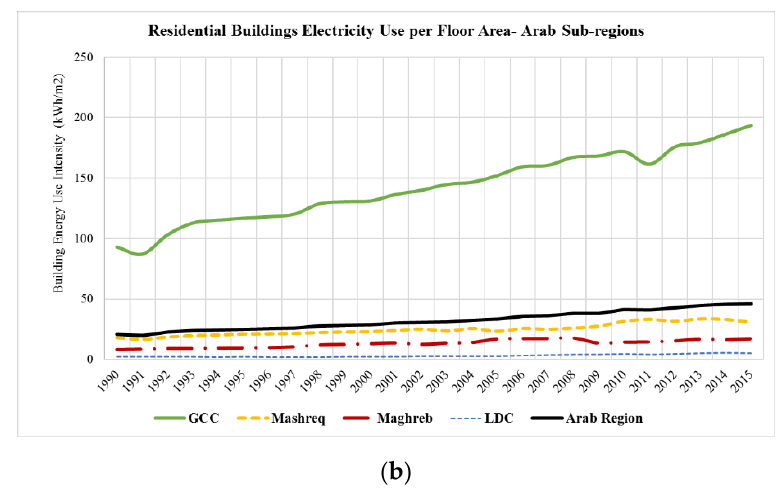
Figure 18. Annual residential buildings energy use intensity for ( a ) total energy use and ( b ) electricity consumption specific to the Arab Region and its sub-regions during the 1990–2015 period. Table 10. Estimation of EUI for residential buildings based on data reported for three Arab countries.